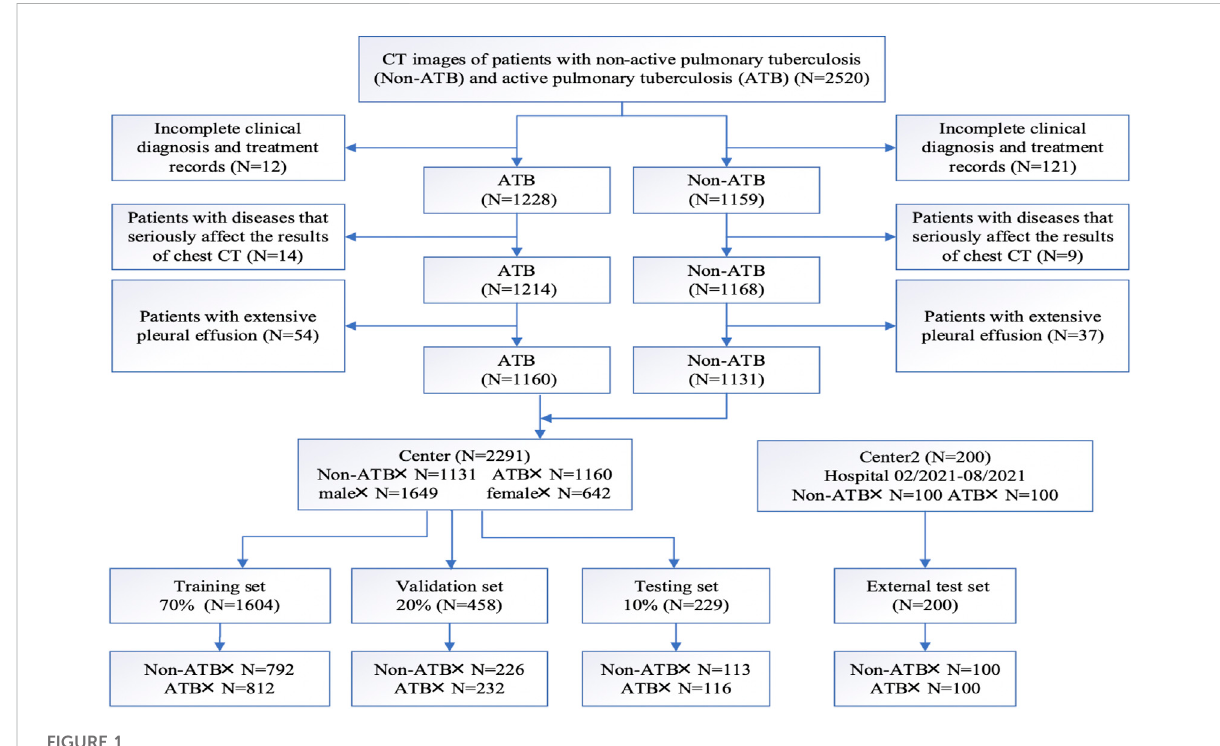
FIGURE 1 Patient inclusion and exclusion